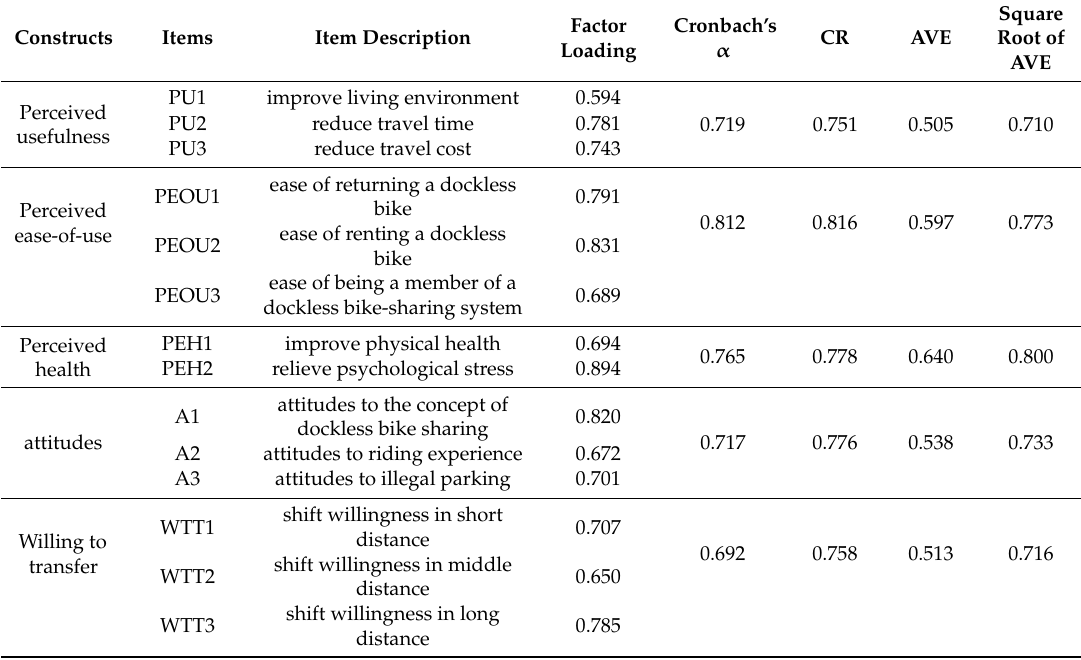
Table 2. Statistics of the measurement model. AVE: average variance extracted, CR: composite reliability.